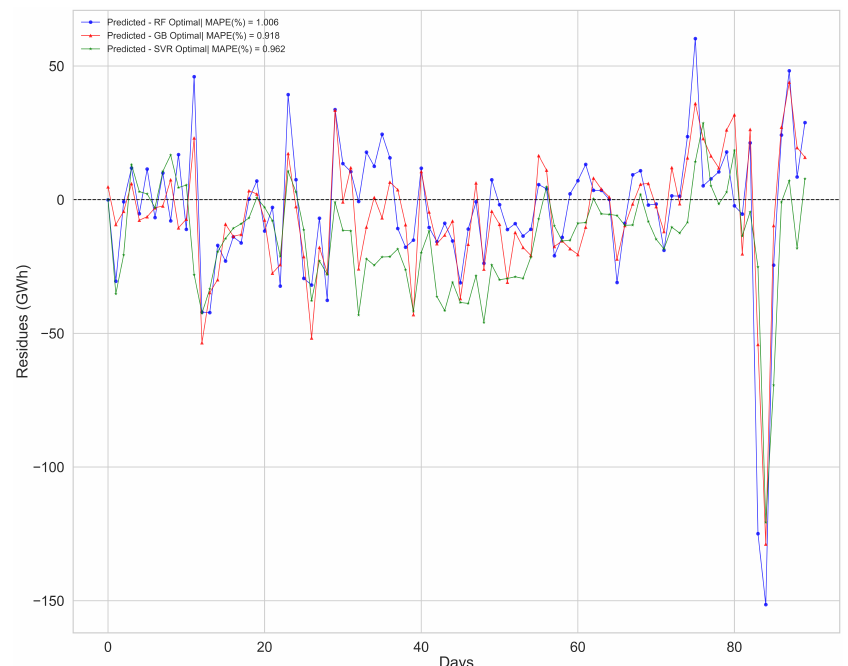
Figure 11. Energy Load residues, as obtained by the optimized models, for the first quarter of 2018.